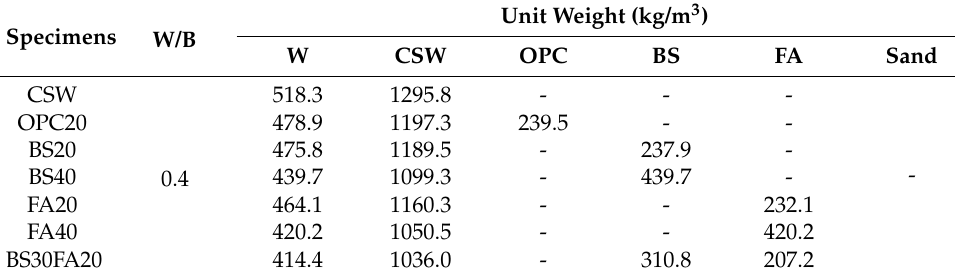
Table 4. Mixture proportion—paste.